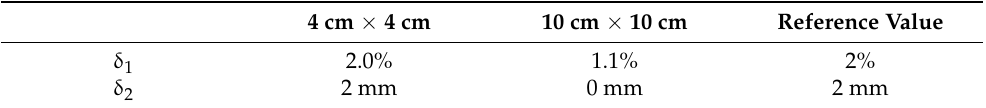
Table 4. PDD evaluation of measured and simulated values for Varian Clinac 6MV: It was evalu- ated by dividing by field size (4 cm × 4 cm, 10 cm × 10 cm). For δ 1, which represents fall - off region after build - up area, both field sizes were within the criterion. Additionally, discrepancy of build - up region, δ , was 2 mm and 0 mm, respectively. 2